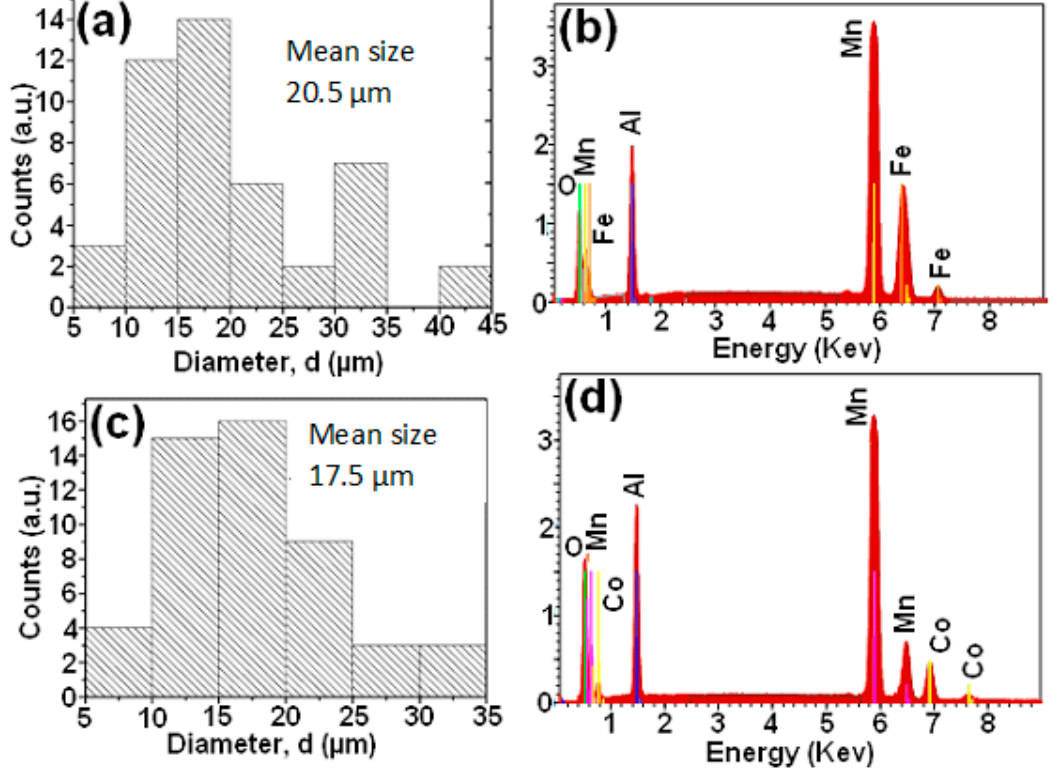
Figure 7. Distribution of particle sizes of MA powders after decoloring reaction: ( a ) Mn-Al-Fe, ( b ) Mn-Al-Co. EDS microanalysis: ( c ) Mn-Al-Fe and ( d ) Mn-Al-Co.